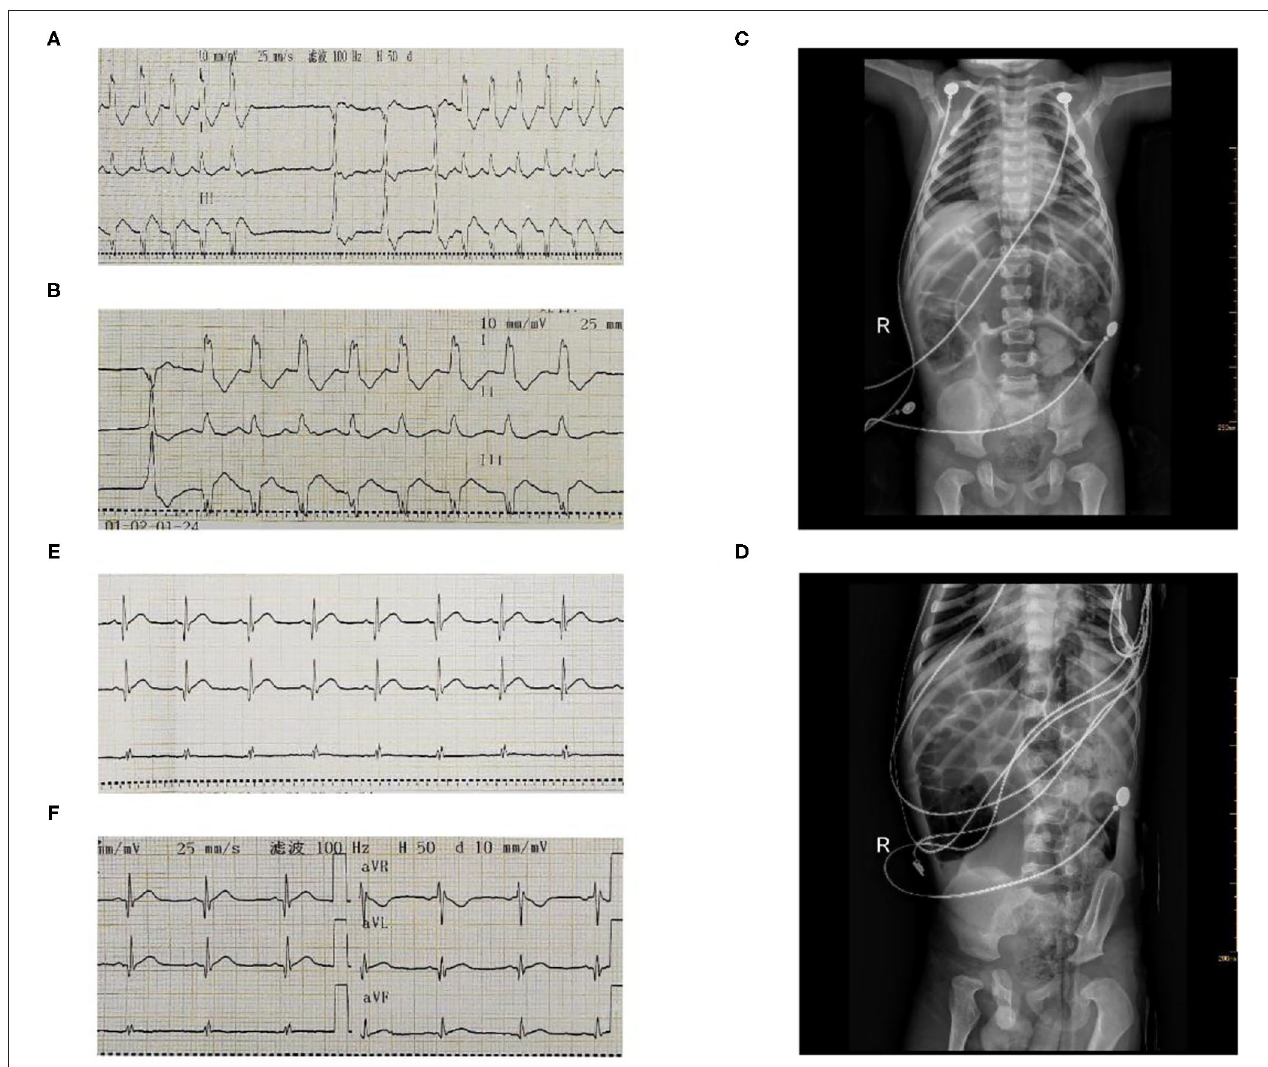
FIGURE 1 | The ECG and chest radiograph of the patient before thyroxine supplementation (A–D) . Follow-up with cardiologist and endocrinologist for repeat ECG in 4 weeks (E,F)